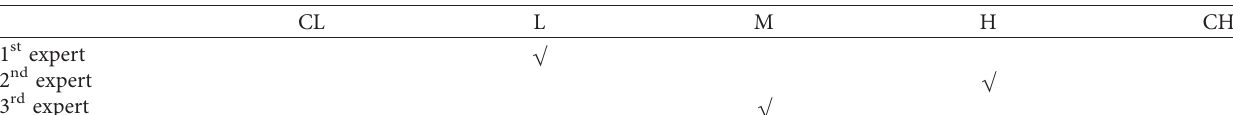
Figure 6: Value vs. L . Table 1: Weights of C1.